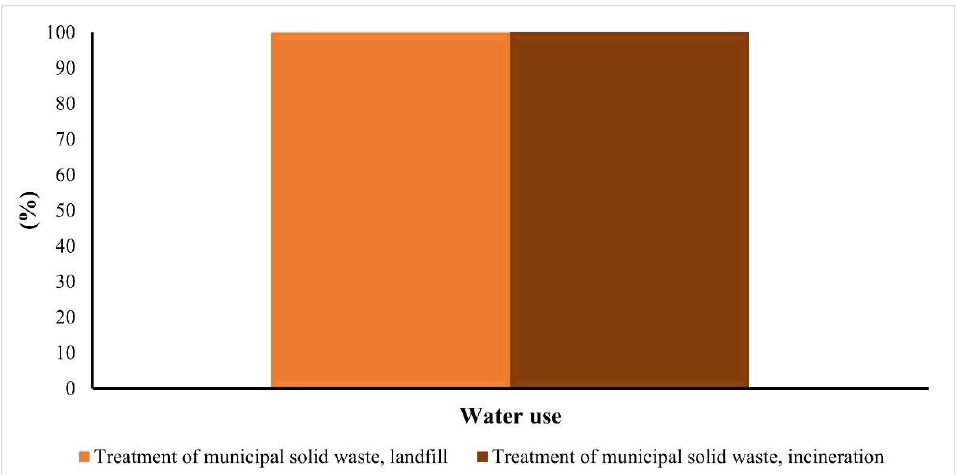
Figure 12. Relative environmental impacts of CD-1 for incineration and landfill disposal scenario, applying AWARE method.